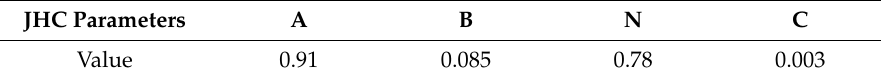
Table 3. Johnson–Holmquist–Cook parameters of single crystal